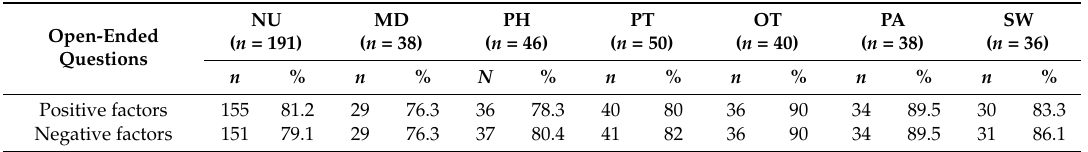
Table 5. Positive and negative percentages from each